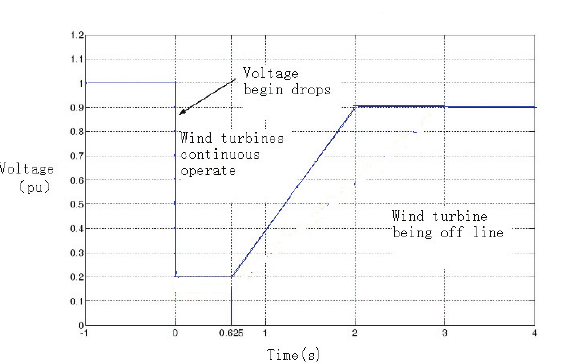
Fig.1. The regulation of wind farm LVRT ability in